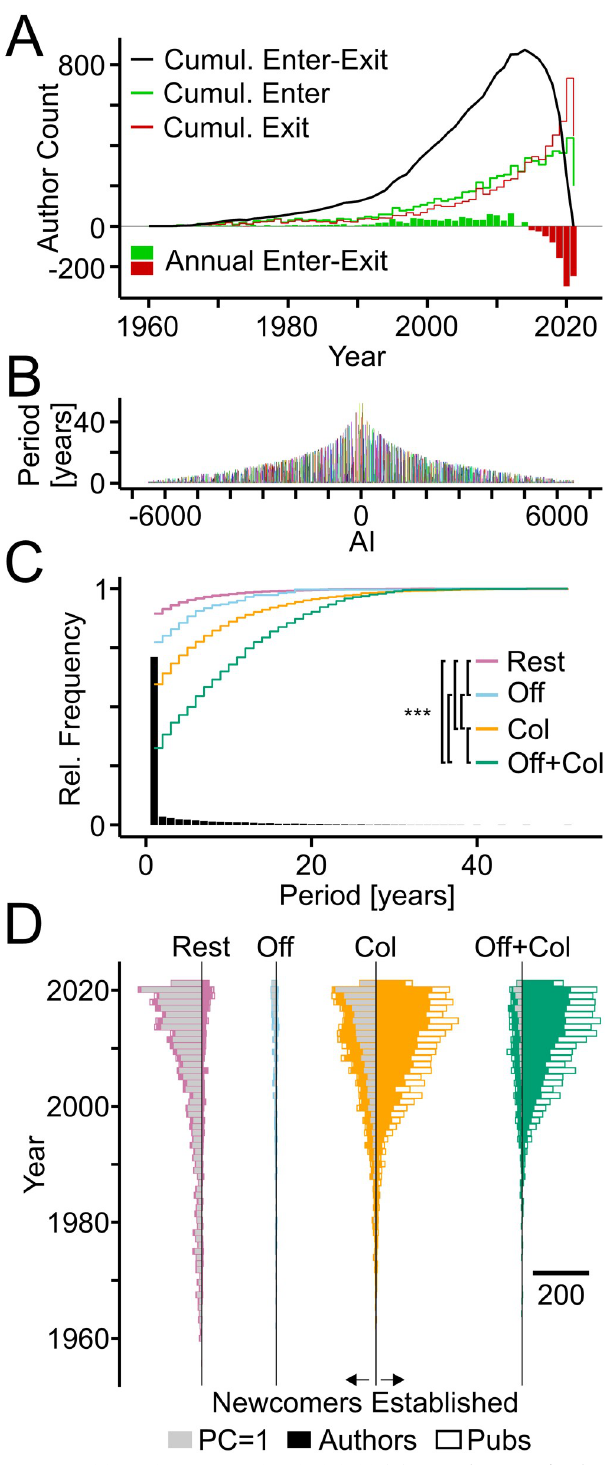
Fig 6. Workforce dynamics in the Clock field. (A) Annual counts of authors entering (green bars) and leaving the field (red bars). Lines indicate cumulative sums. (B) Publication periods of individual authors in years. (C) Bars and lines showing the relative frequencies of all publication periods and the cumulative relative frequencies of publication periods of authors from indicated categories, respectively. Col, authors with collaborative but no genealogical connections; Off, genealogical but no collaborative connections; Off+Col, both types of connections; Rest, without connections. Statistically significant differences among groups are indicated (Kruskal-Wallis tests chi-squared = 265.12, df = 3, p < 0.0001. Asterisks indicate level of significance: ��� , p < 0.001; post-hoc Dunn